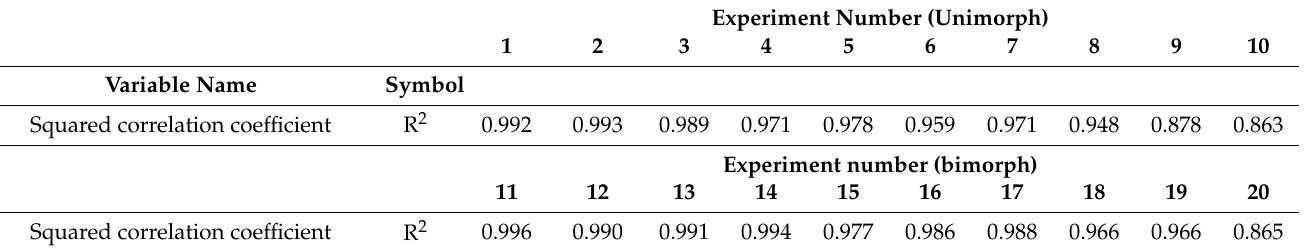
Figure 16. Approximated hysteresis errors ( a ) in the unimorph movement, and ( b ) in the bimorph movement, for u 2min = –u 1max .